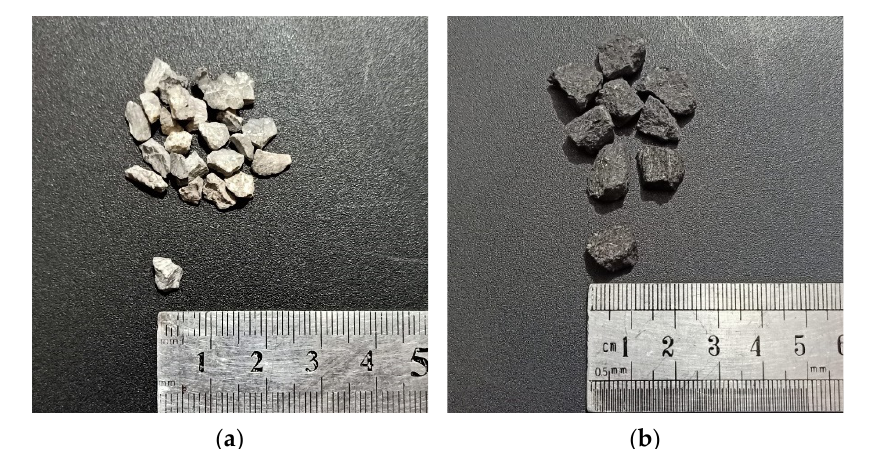
Figure 2. ( a ) Margala crush 5 mm and ( b ) granite crush measuring 10 mm. Table 2. Mix proportions of the control mix.